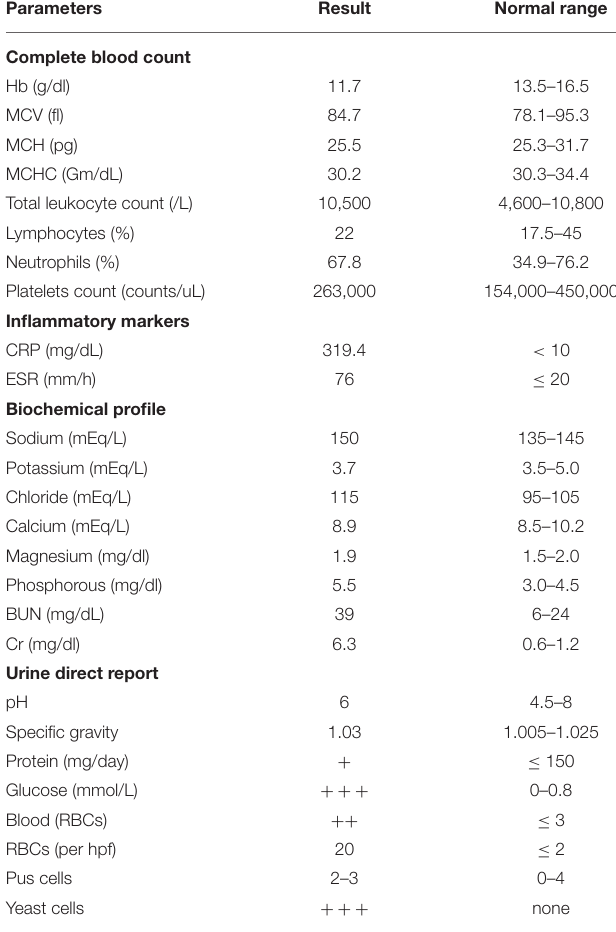
TABLE 1 | Baseline investigations of the patient on